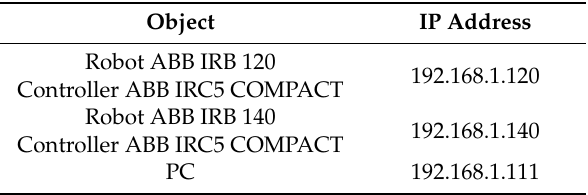
Table 1. Slave Configuration.